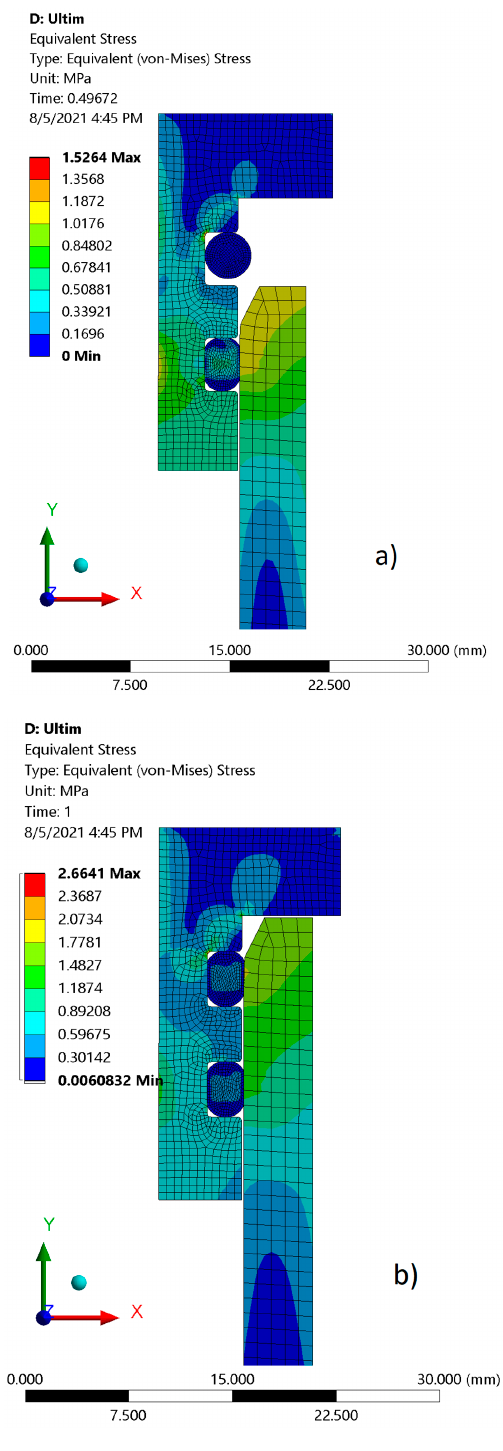
Figure 6. Particular case: the shear force T 0 acts at a distance L from the end of the cylinder. ( a ) is the beginning of pushing the sealing cover, and ( b ) is the end of closing the sealing cover. You can also see how the stresses inside the rubber gaskets change.